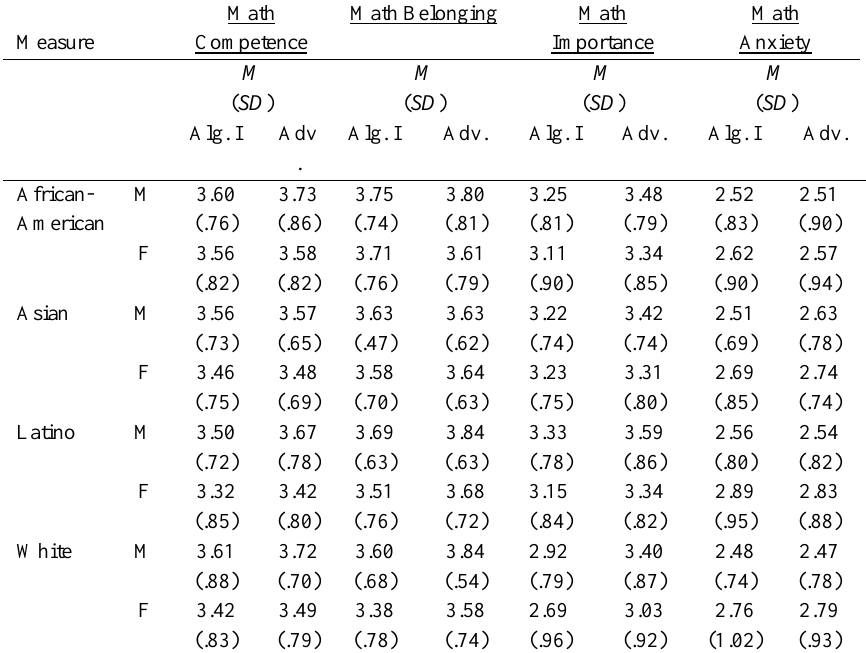
Means and standard deviations of each math attitude as a function of ethnicity, gender and math level Measure